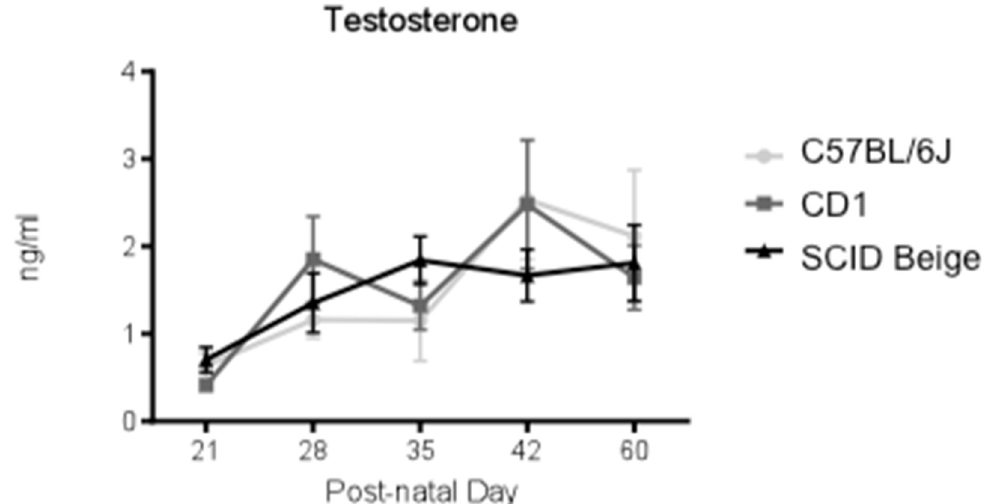
Figure 4. C57BL/6J, CD1, and SCID Beige testosterone plasma level (ng/mL) at different postnatal days. Data are expressed as mean ± SEM. We analyzed 10 animals per strain and age.